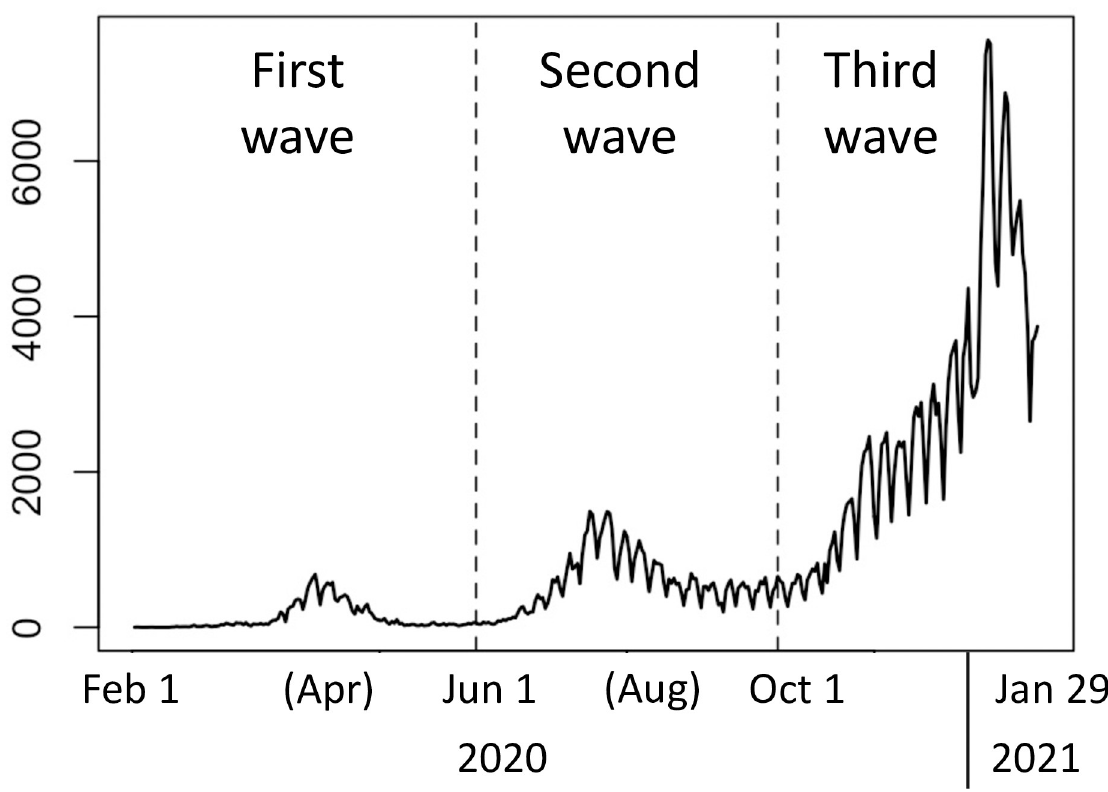
Fig 13. Daily number of cases across